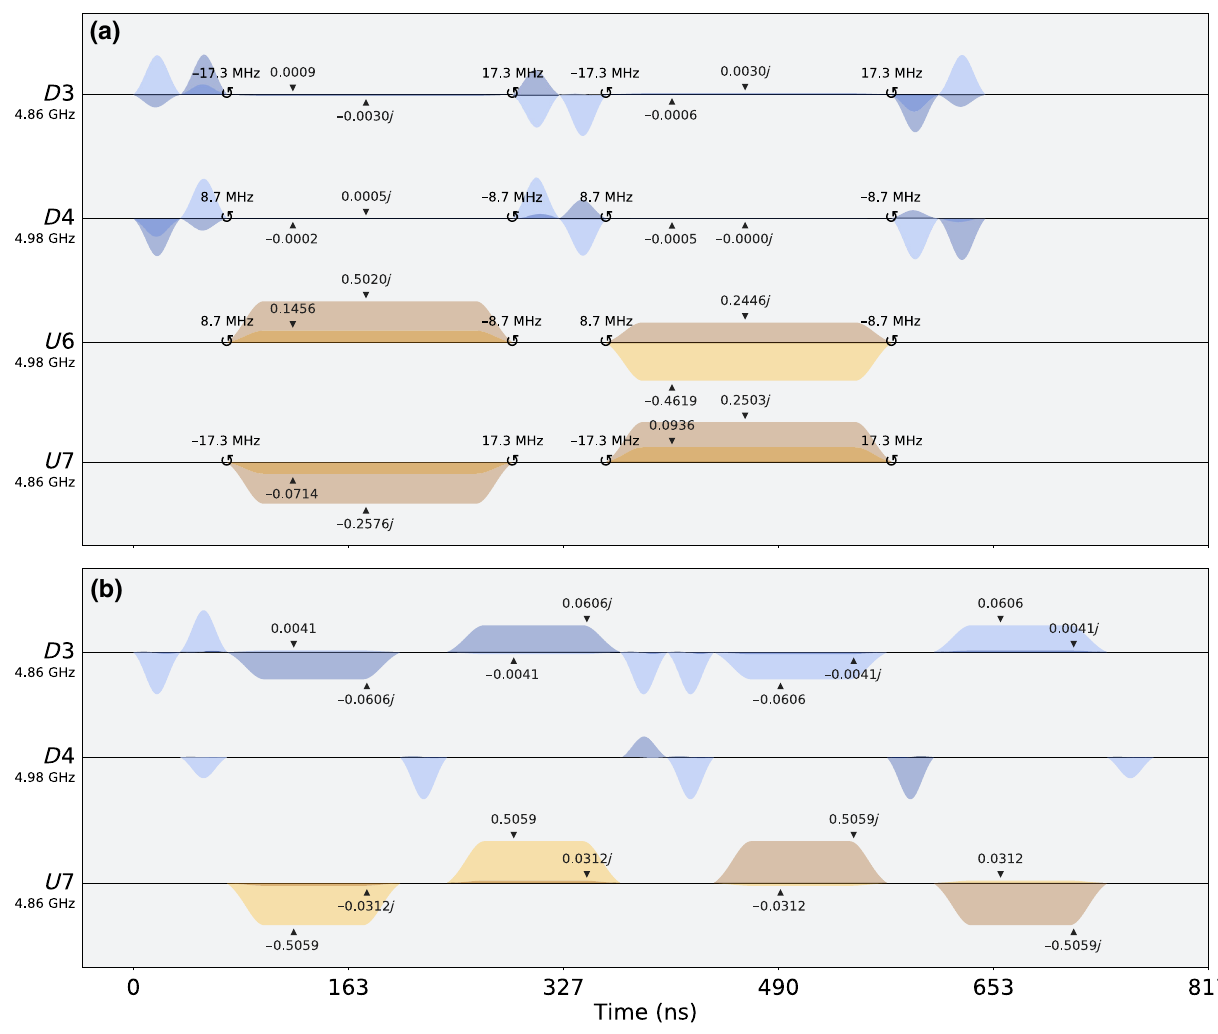
FIG. 8. Pulse schedules for i SWAP gates with different implementations: (a) CCR gates and (b) TPCX gates. Each horizontal line corresponds to a pulse channel associated with a qubit in a specific frame. Channel names are shown on the left side, with the frequency assigned to the channel. Curly arrows indicate the frequency shift of the channel. These frequency shifts are introduced to correct drive- induced Stark shifts. The pulse amplitudes of the real and imaginary parts of the CCR and CR gates are also shown by triangle signs, where the ratio of the CR pulse amplitudes with which channels U 6 and U 7 are irradiated is designed to compensate for the different execution rates of the CR gates owing to finite